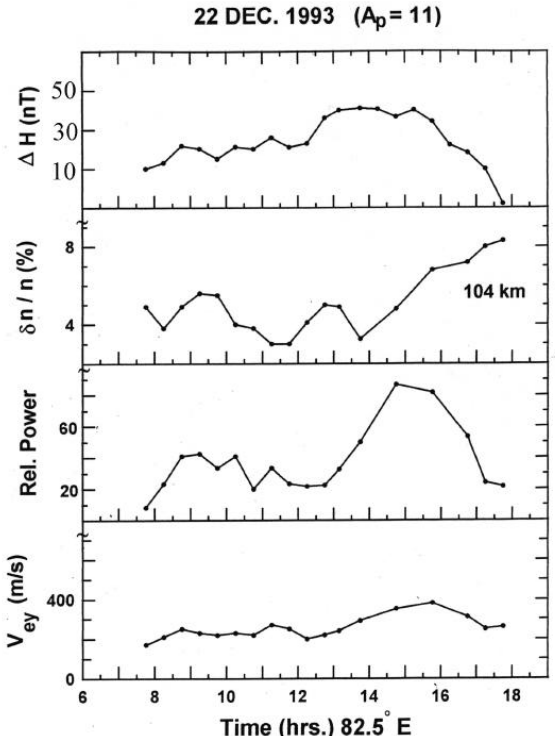
ey , relative power, δ n/n at 104km and 1 H at Trivandrum on 22 December 1993.